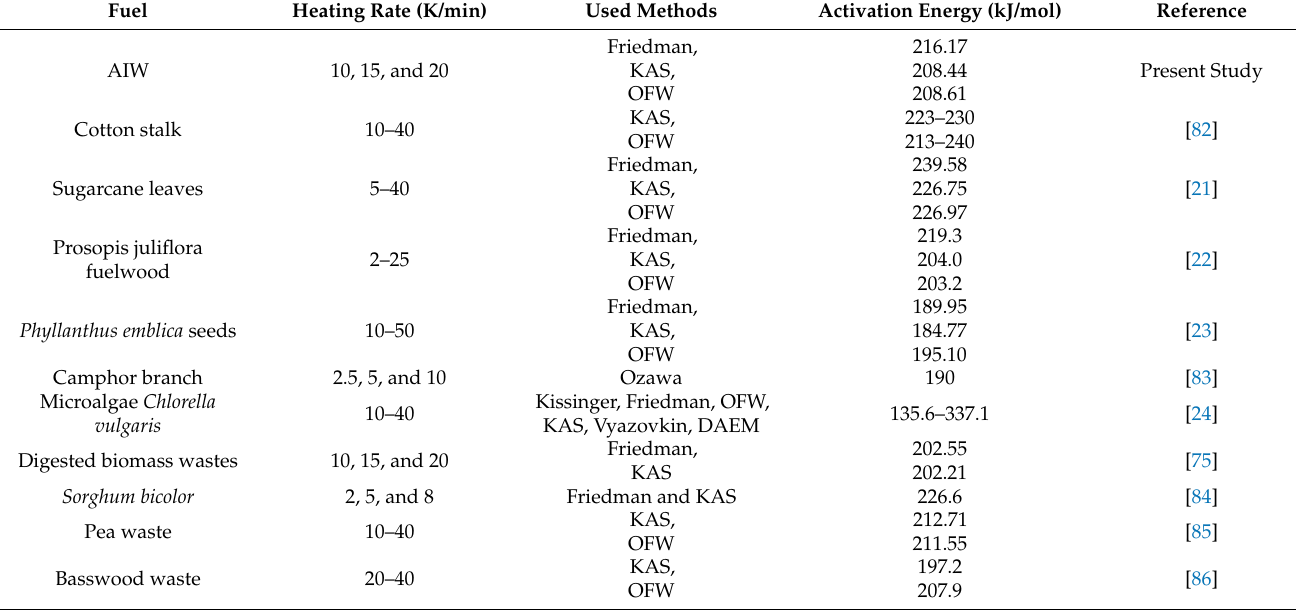
Table 8. Comparison of biomasses activation energy.